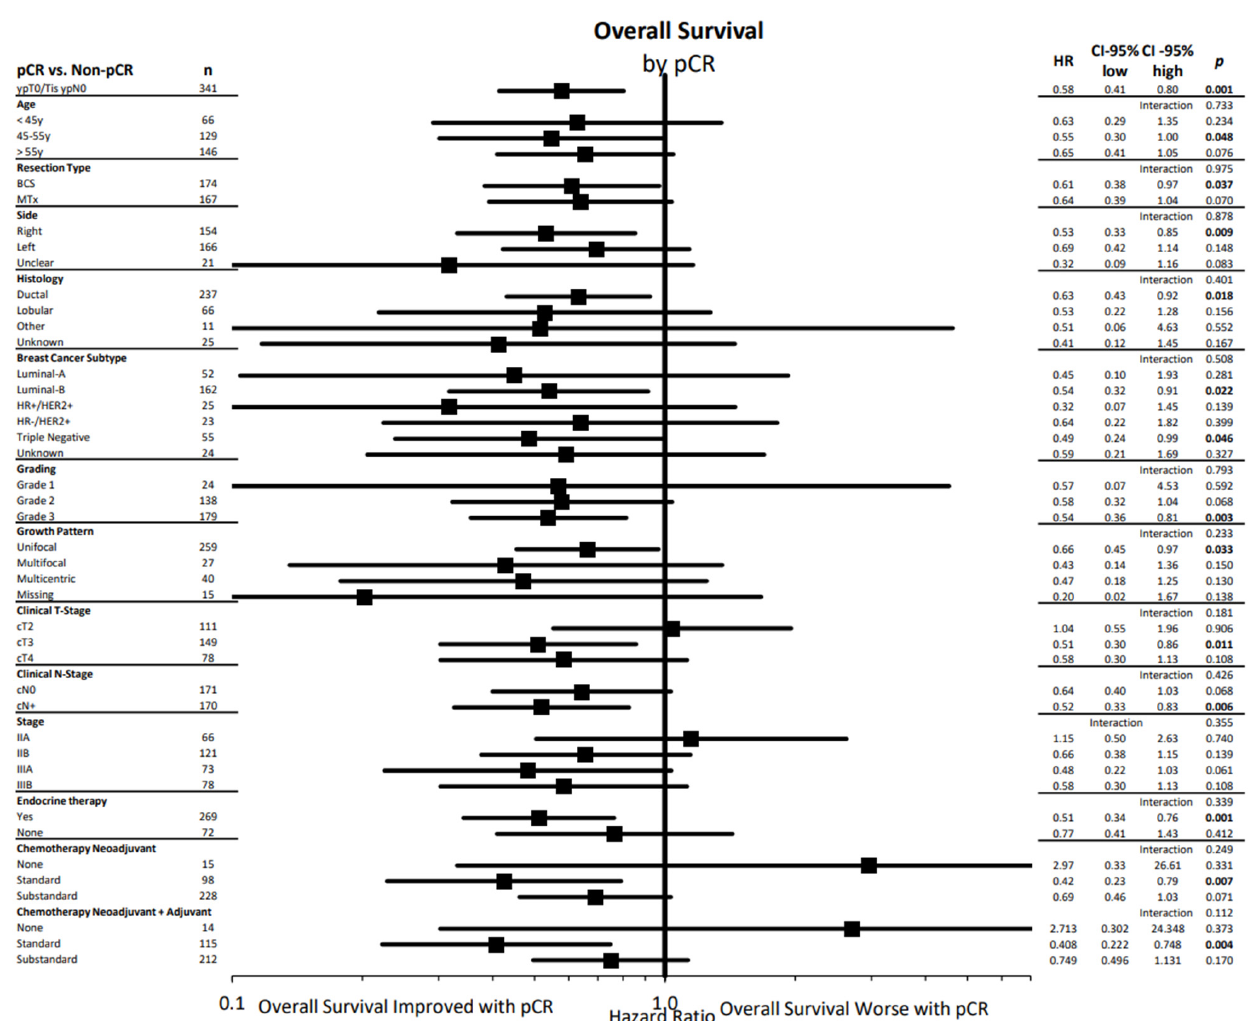
Figure 2. Cox regression analysis of overall survival by pCR-status (yes vs. no) status in different subgroups with hazard ratios, their corresponding confidence intervals and fitting interaction tests presented in a forest plot. pCR: pathologic complete response, BCS: breast-conserving surgery, MTx: mastectomy, HR+: hormone receptor positive, HER2: human epithelial growth factor receptor 2, c: clinical, T: tumor, N: nodal, G: grading, HR: hazard ratio, CI: confidence interval. Statistically significant differences are marked in bold.